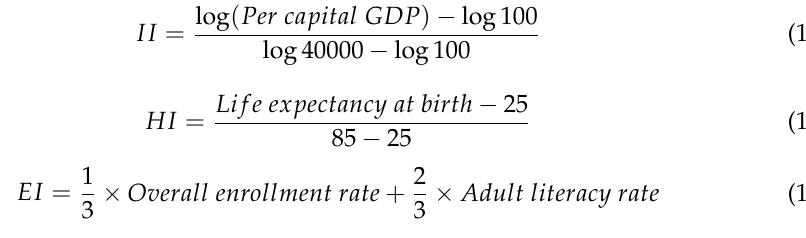
Table 4. The index benchmark of Human Development Index (HDI). Index